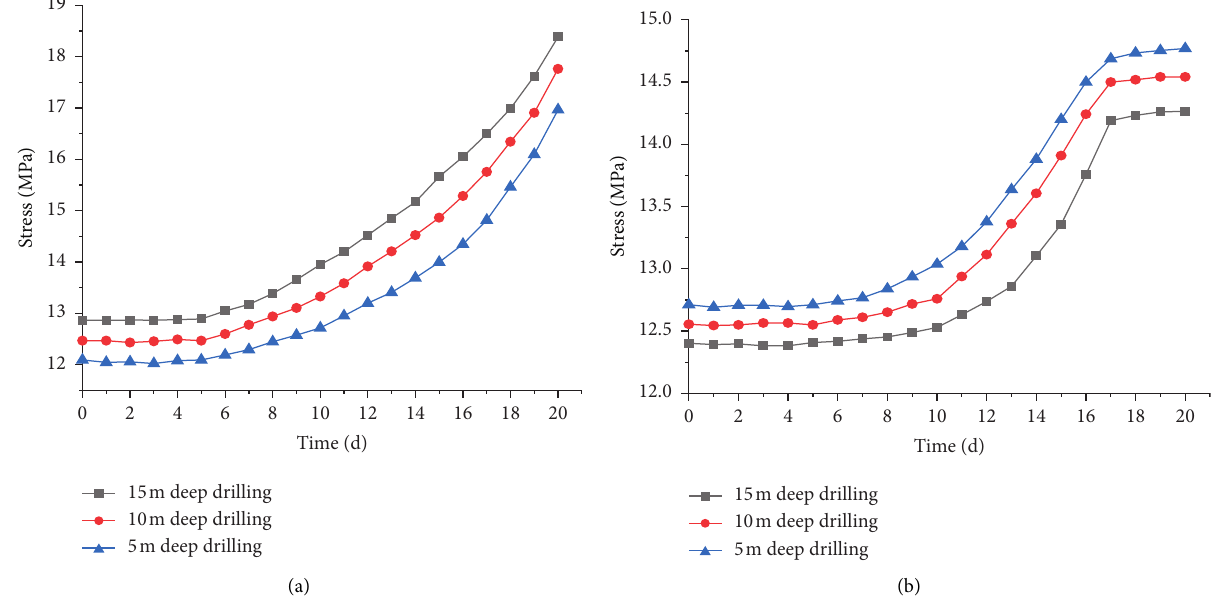
Figure 15: Abutment pressure monitoring curve. (a) Station 1. (b) Station